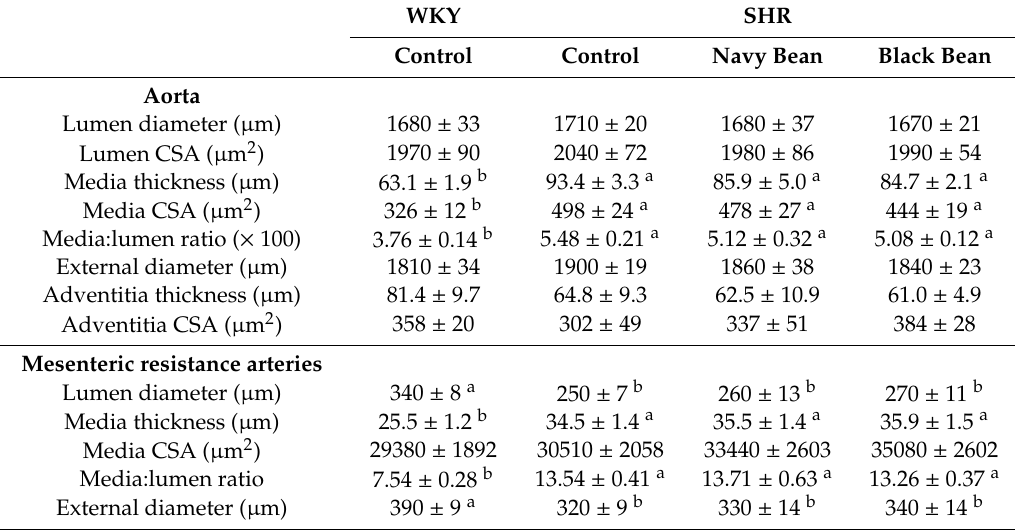
Table 4. Phase 1: Vascular